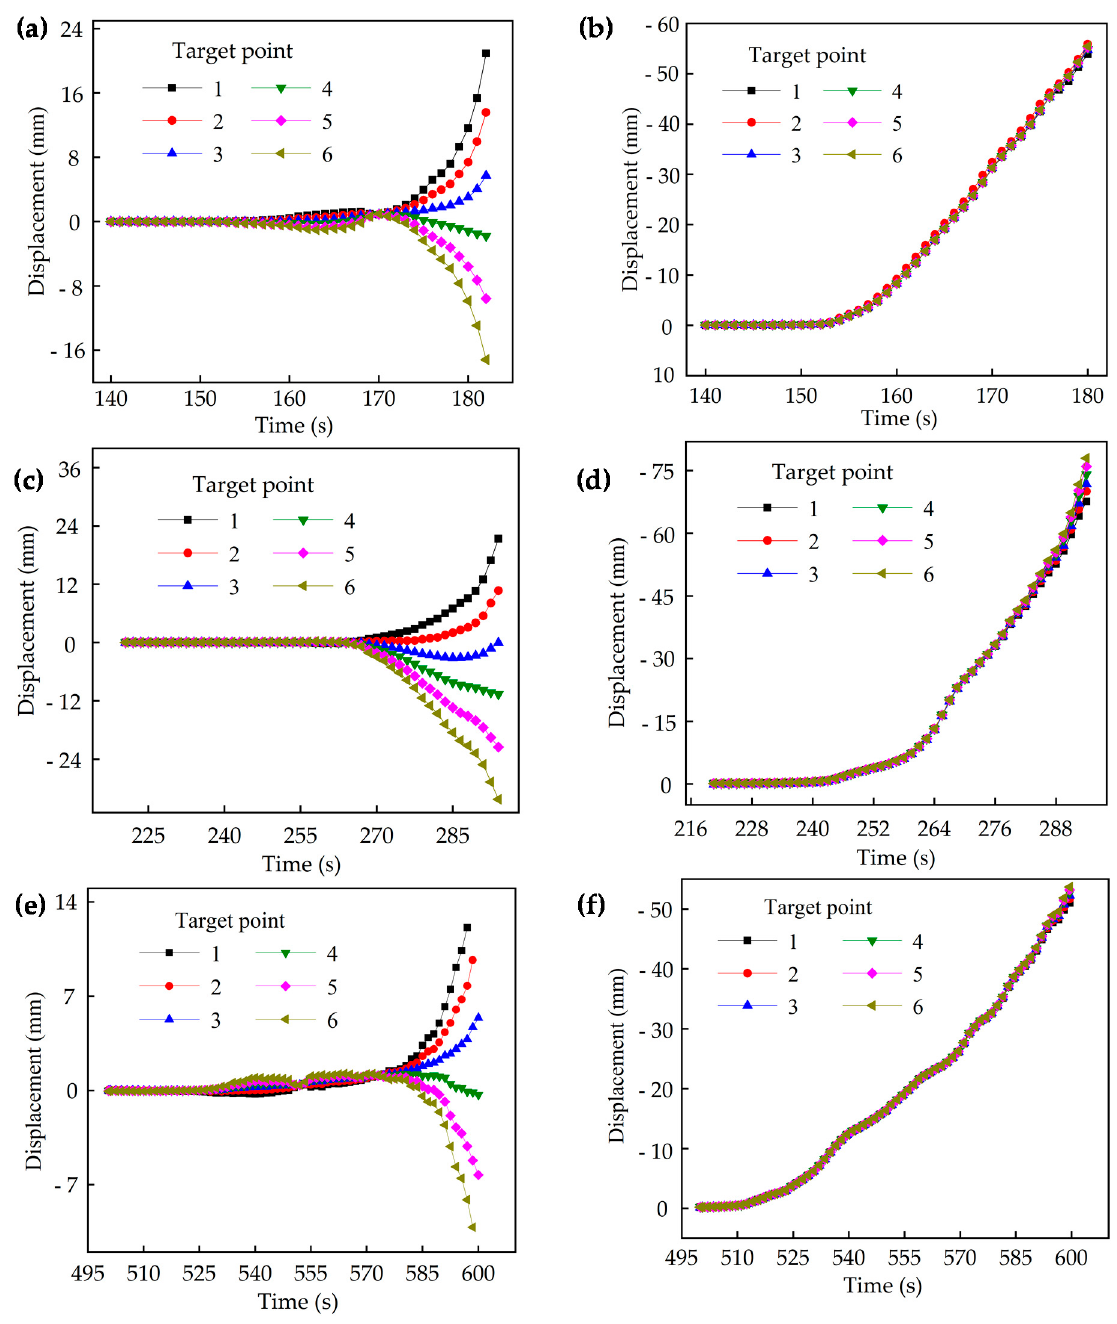
Figure 6. The displacement–time curves of target points: ( a ) horizontal direction for loose sands; ( b ) vertical direction for loose sands; ( c ) horizontal direction for medium dense sands; ( d ) vertical direction for medium dense sands; ( e ) horizontal direction for dense sands; ( f ) vertical direction for dense sands.